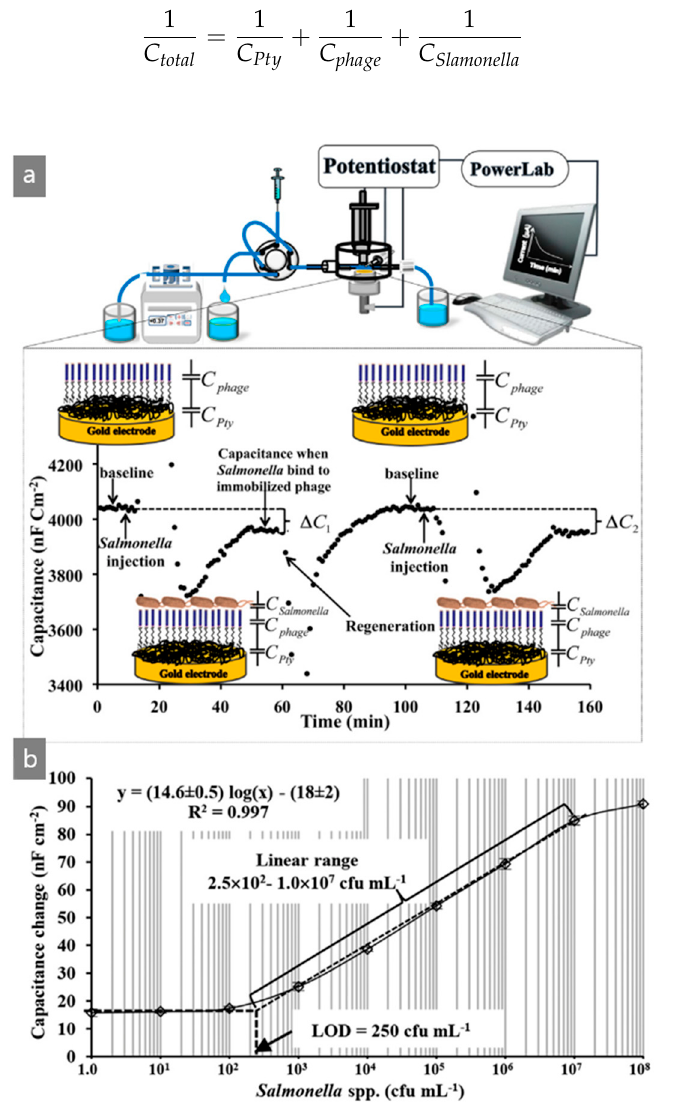
Figure 6. ( a ) Schematic procedure of the capacitive flow injection system for sensing Salmonella spp. using a M13 bacteriophage-based electrode sensor and ( b ) linear response of the sensor by number of Salmonella spp. Reproduced from [48], with permission from Elsevier, 2018.